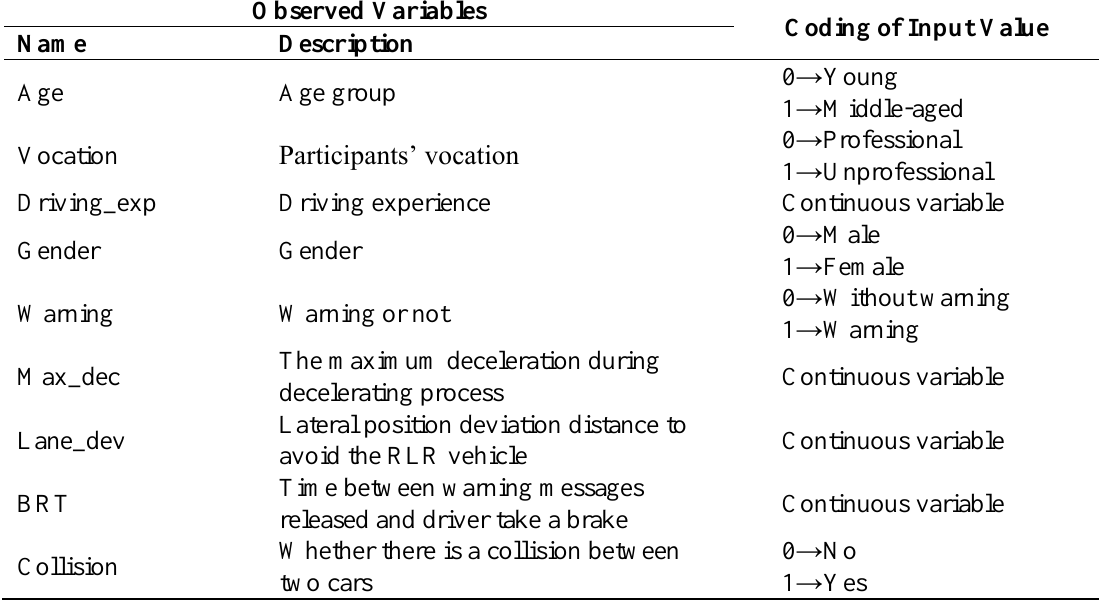
Table 9. Definition of variables in SEM models.